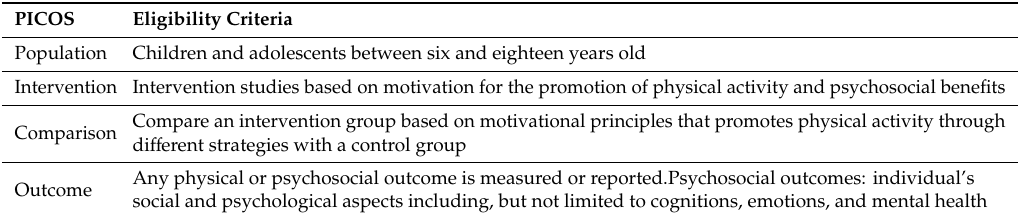
Table 1. Study selection